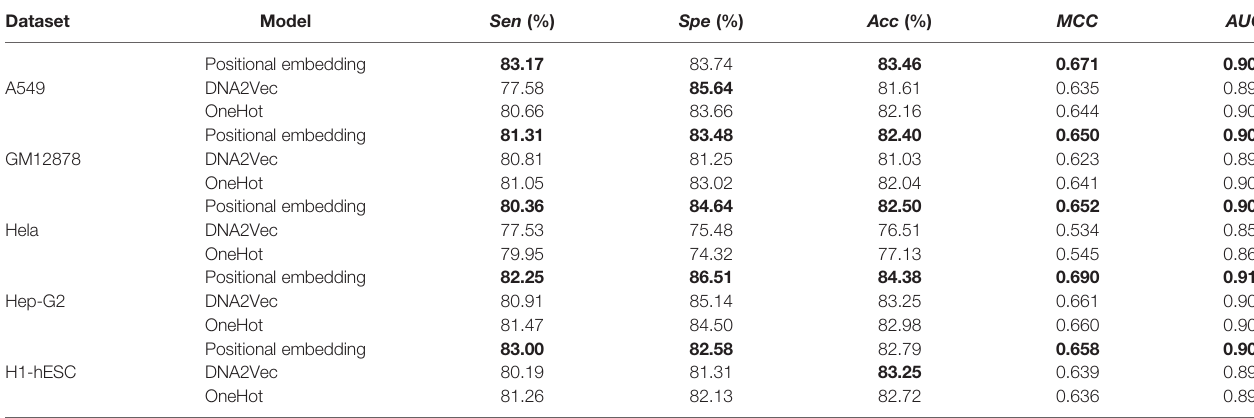
TABLE 3 | Performance comparison of OneHot, DNA2Vec, and positional embedding.